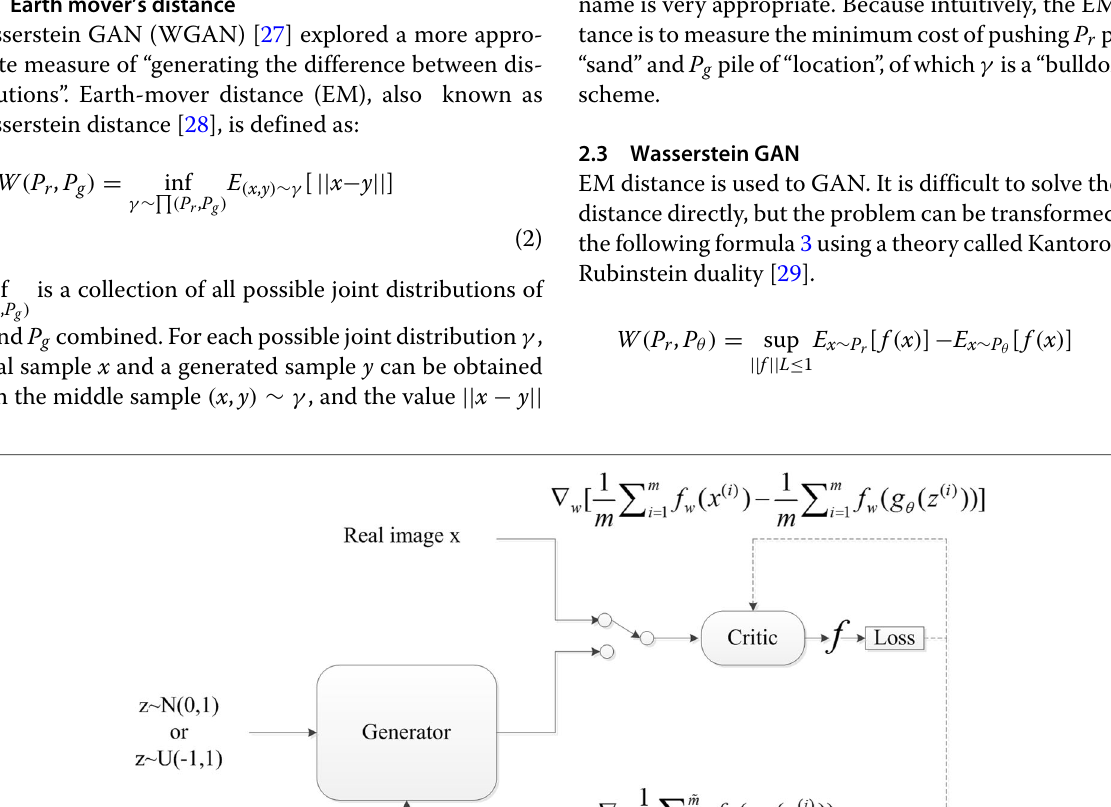
trained too weakly, the indicator effect is not significant, and the generator will not be able to learn effectively. In this way, the training of discriminator is difficult to con- trol, which is the root of the difficulty of GAN training. The emergence of WGAN solves this problem.